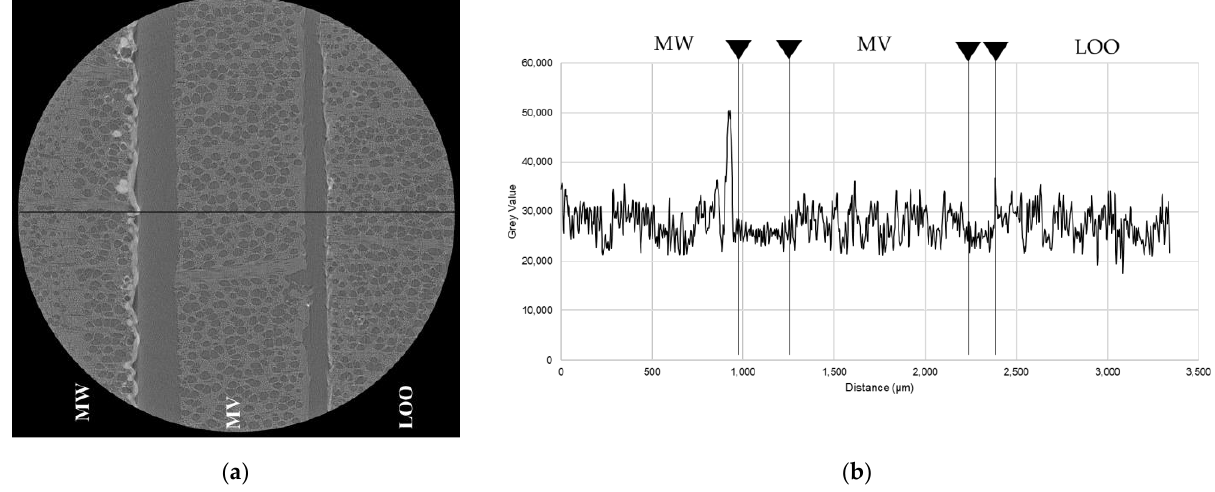
Figure 12. Sample series 2 Mo target with Al filter up side (MW, MV, LOO); ( a ) visualization result and the plot profile line; ( b ) plot profile graphic.